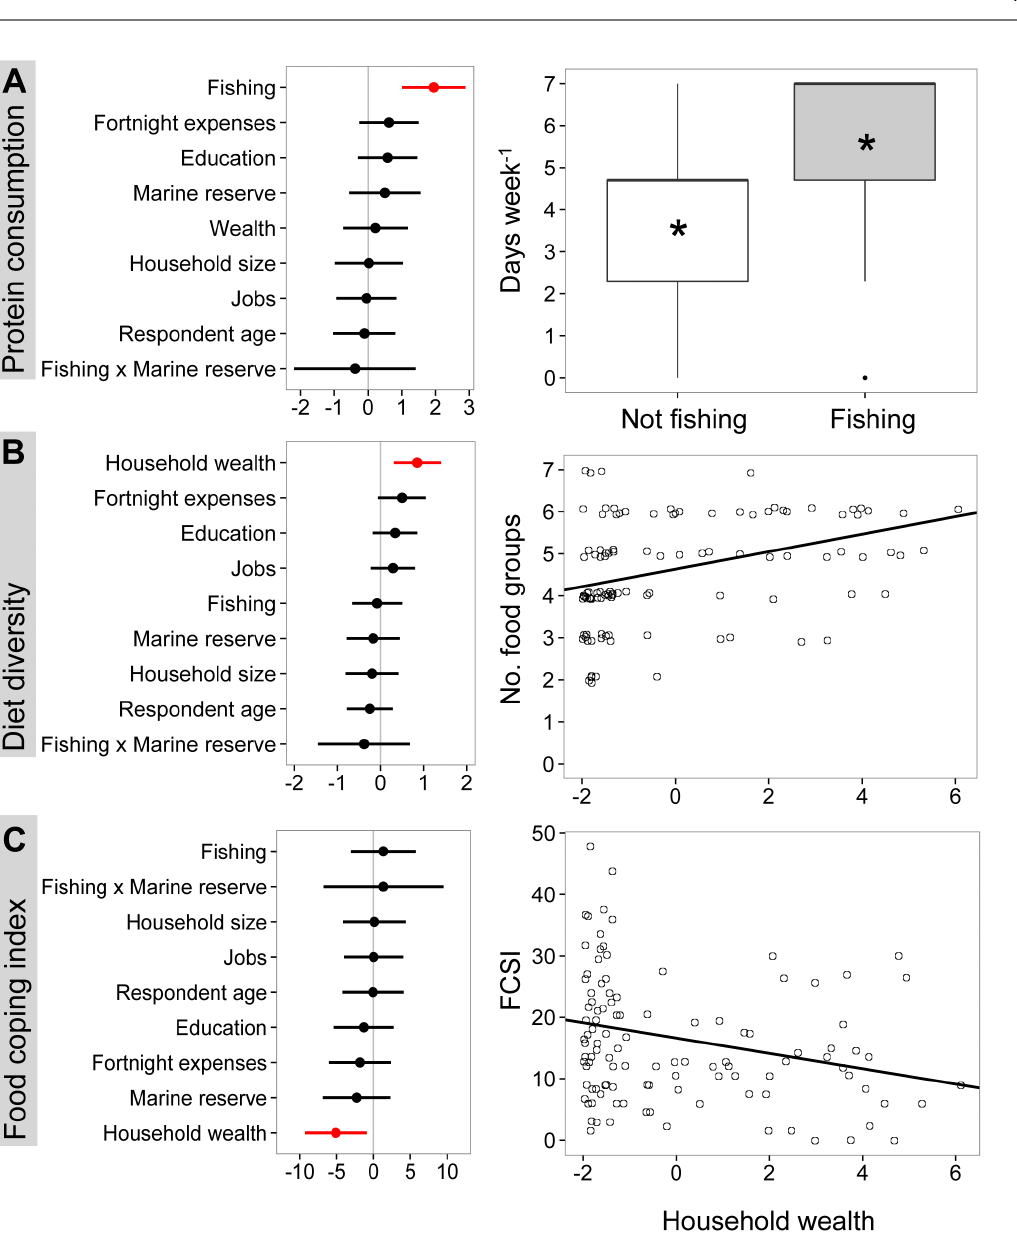
Figure 1. Importance of socio-economic characteristics and proximity to marine reserves for household food security in Kenyan coastal communities. Food security was described by three metrics: (A) protein consumption, (B) diet diversity and (C) food coping strategies. Panels on the left show averaged effect sizes and 95% confidence estimates from multi-model averaging; the line at zero indicates no effect. Significant predictors (where the 95% confidence interval does not overlap zero) are highlighted in red. Panels on the right show the direction of significant predictors. For (A), boxplots show medians (thick horizontal lines) with first and third quartiles (boxes), 95% confidence intervals (whiskers) and one outlier (point); asterisks indicate mean values of each group. For (B) and (C), a linear relationship is shown based on model-averaged coefficients. Household wealth is derived from a Material Style of Life principal components axis described in Figure